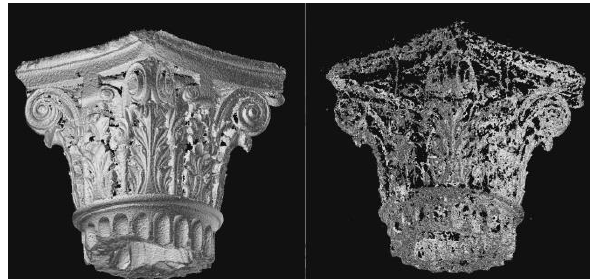
Figure 2: Partially reconstructed scenes of full spectrum (left) and UVAb (right) datasets of OBJ2 with 3DFlow Zephyr SL1 1200D full